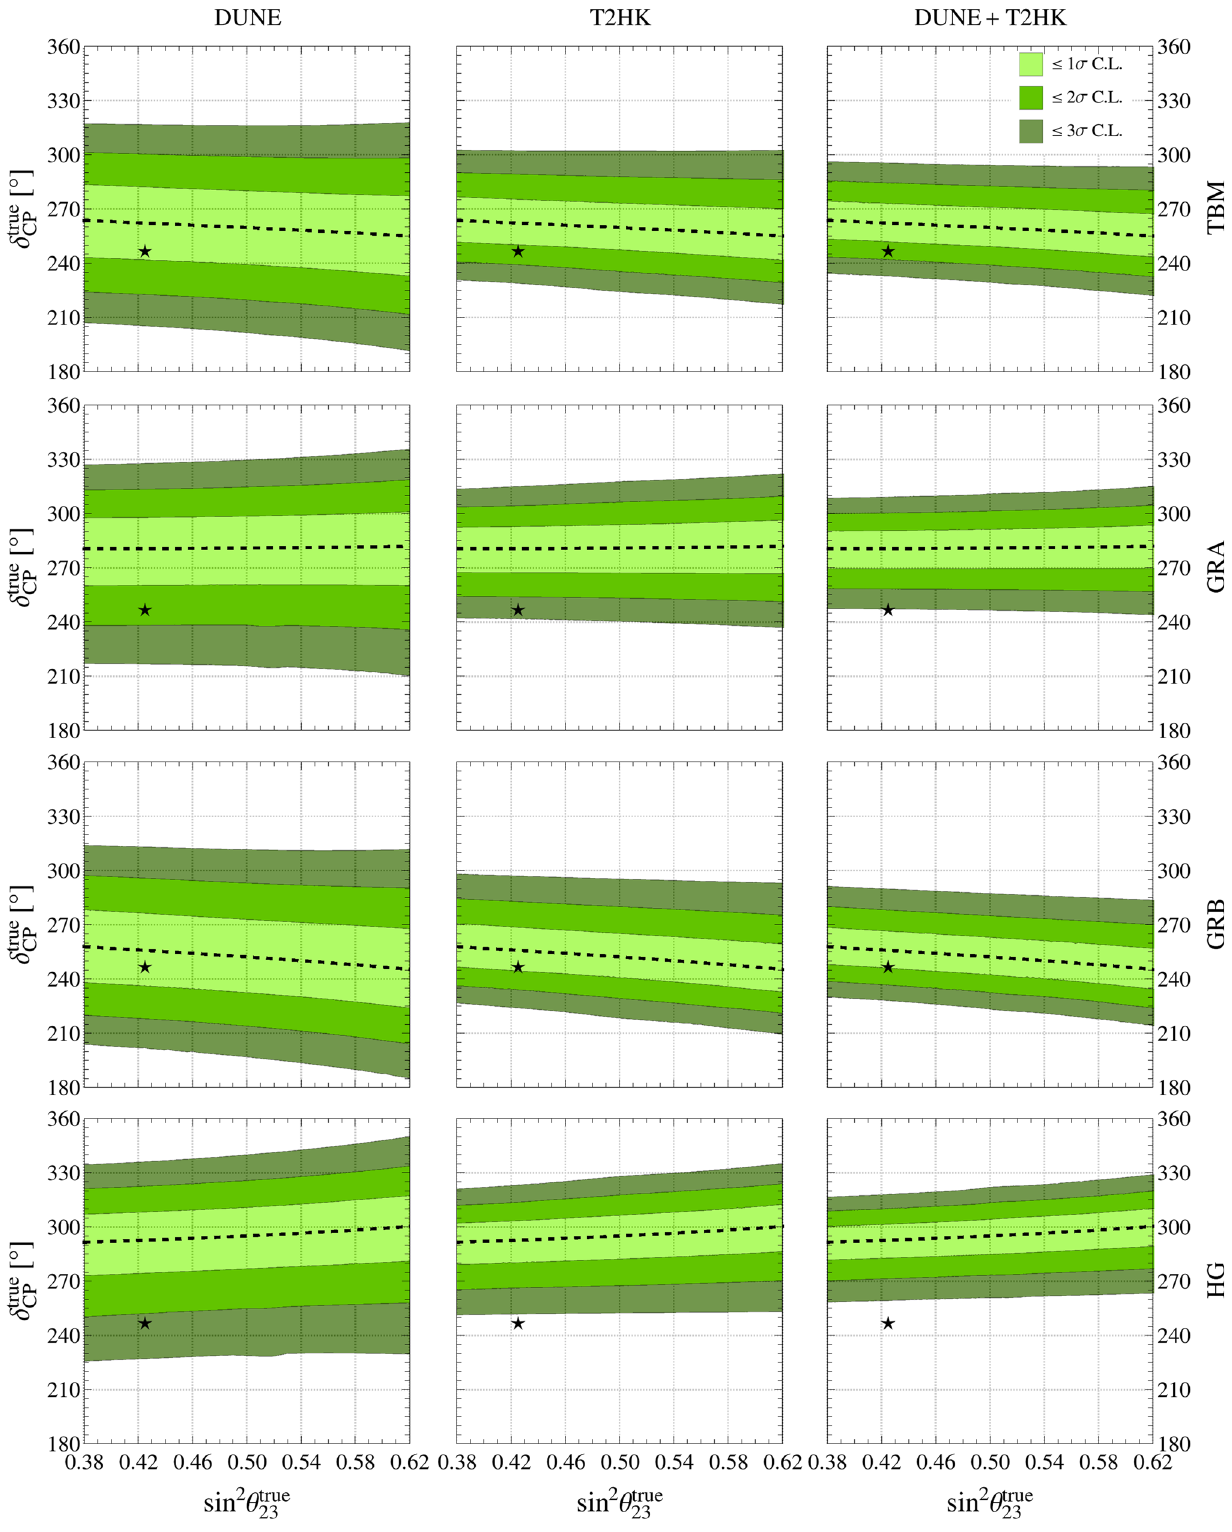
Fig. 6 Compatibility of various symmetry forms with any potentially using Eq. (1.1) and fixing θ 12 and θ 13 to their NO best fit values. The true values of sin 2 θ 23 and δ CP in the context of DUNE (left panels), star indicates the present best fit values for NO as given in Table 1. For all the symmetry forms, a significant part of the parameter space gets T2HK (middle panels), and DUNE + T2HK (right panels). For a given disfavoured at more than 3 σ C.L. for DUNE + symmetry form (fixed θ ν ), the black dashed line has been obtained 12